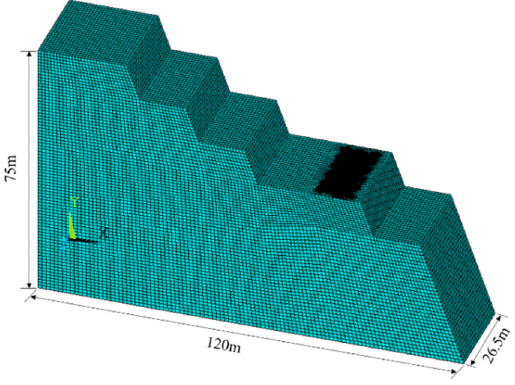
Figure 2. Grid diagram of the numerical model.